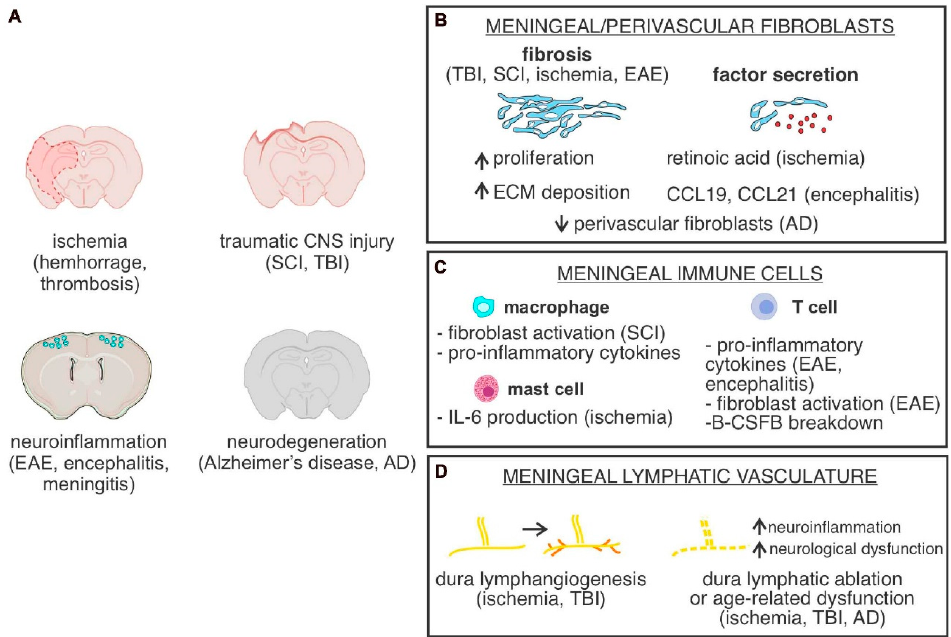
Figure 4. Meningeal tissues or cells in CNS illness or damage (adapted with permission from [108] Frontiers, 2021). ( A ) a CNS injury or illness. ( B ) fibrosis, which is brought on by enhanced perivascular cell growth and extracellular (ECM) accumulation. ( C ) the summary of the functional contributions made by immune cells situated in the meninges in various CNS pathological conditions. ( D ) the summary of the cellular alterations that have occurred in the meninges’ lymphoid system in response to various CNS diseases and